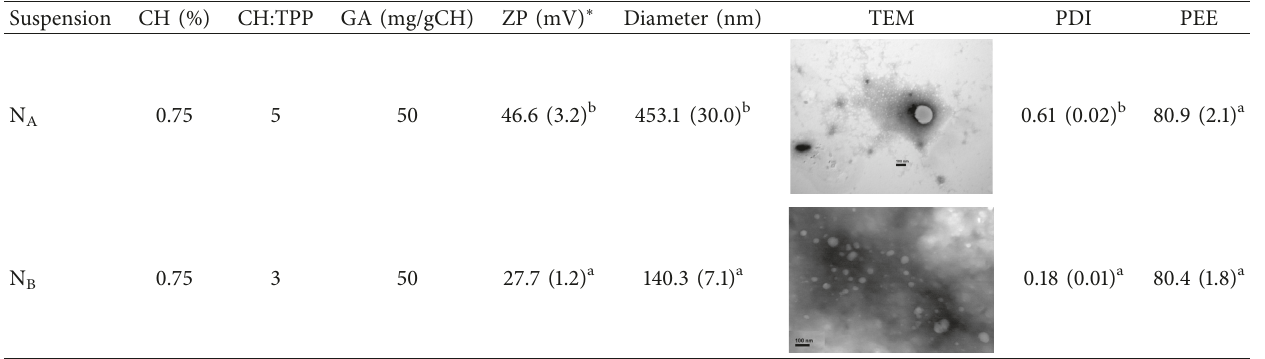
Table 1: Zeta potential (ZP, mV), nanoparticle diameters (nm), TEM micrographs, polydispersity index (PDI), and percentage encap- sulation efficiency (PEE) of N A and N B suspensions. Variables were chitosan concentration (w/w), chitosan:tripolyphosphate ratio (CH:TPP), and gallic acid concentration expressed as mg GA /g CH